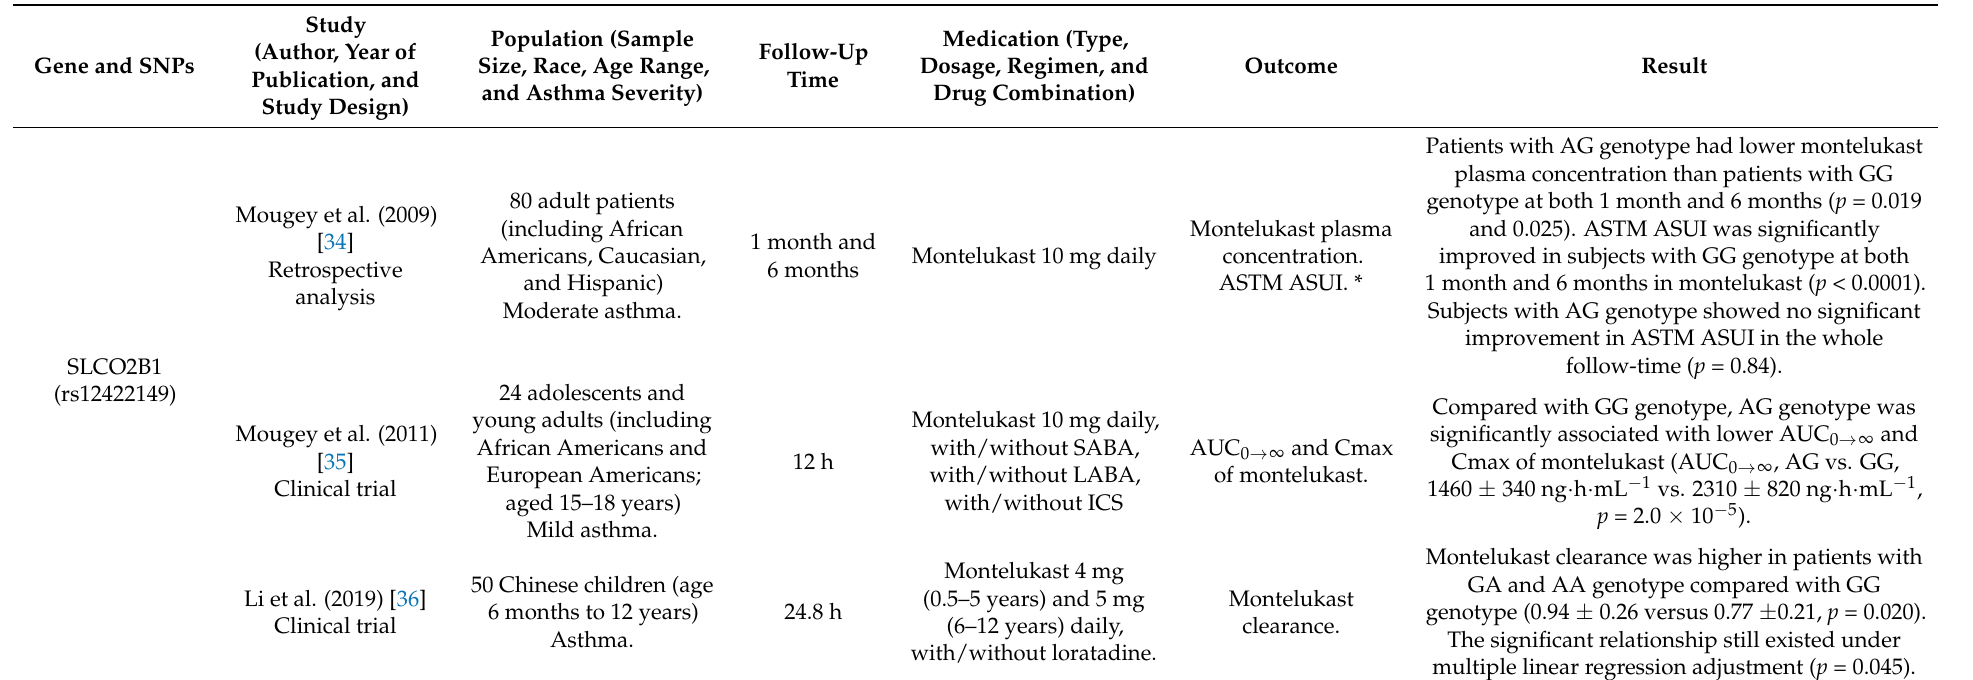
Table 5. SLCO2B1 gene pharmacogenomics studies of response to